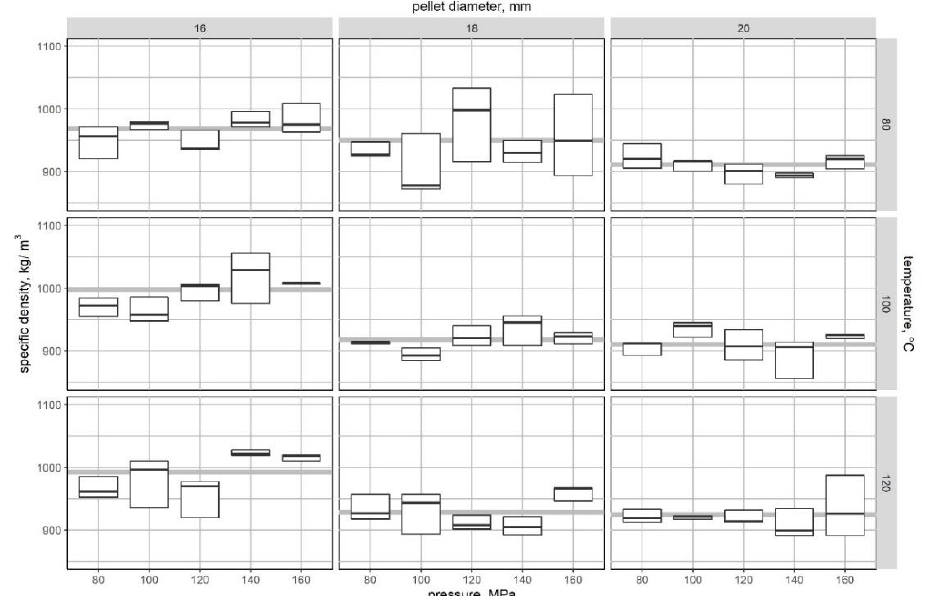
Figure 9. Variation of specific density with compaction pressure, temperature, and pellet diameter. The grey line in each plot represents the average value of each group. Top and bottom of each box represents range of values deviation.